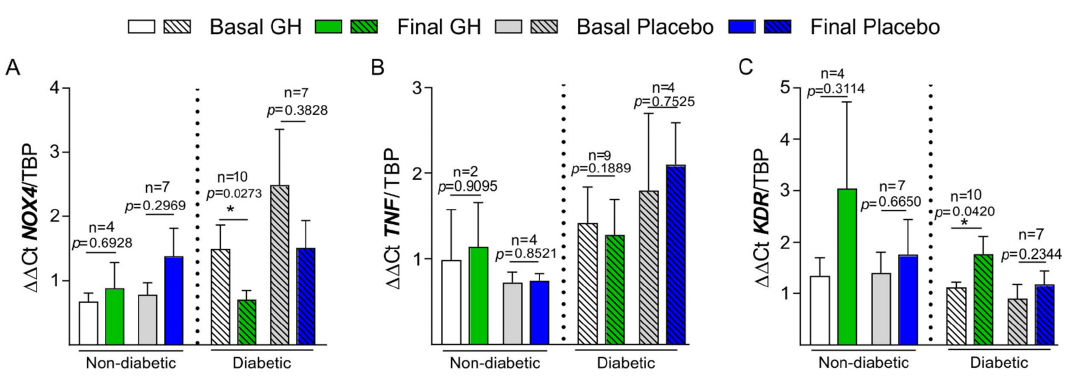
Figure 2. Basal to final mRNA expression of different genes. NOX4 ( A ), TNF ( TNF - α ) ( B ), and KDR ( C ). Findings in both groups, GH, and placebo, with DM and without DM. * p < 0.05.